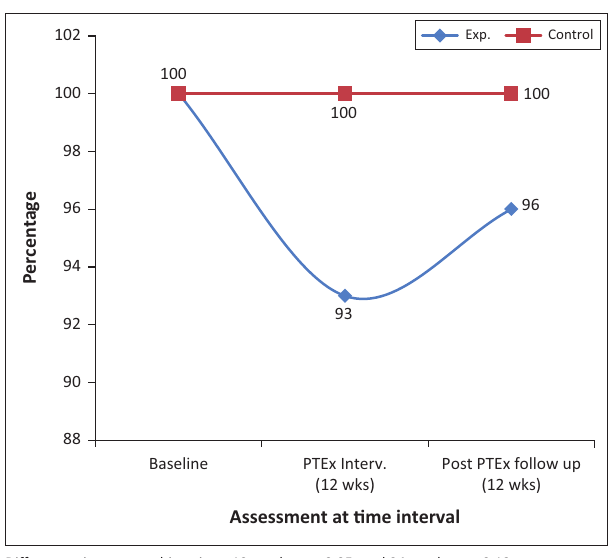
FIGURE 7: The percentages of participants with peripheral neuropathy at baseline, 12 and 24 weeks, in the intervention and control groups.